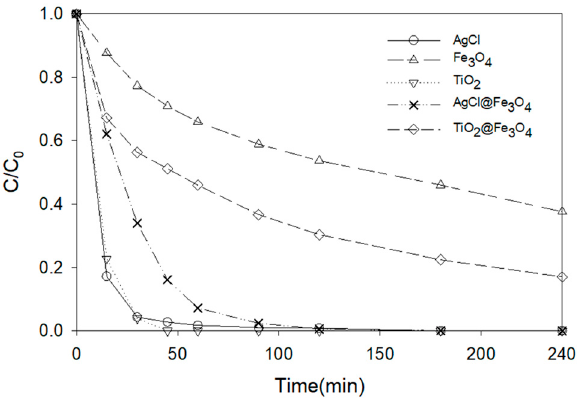
Figure 17. Degradation performances ( C/C 0 ) as a function of time using different nanocatalysts (the lines are only to facilitate the visualization of the results).